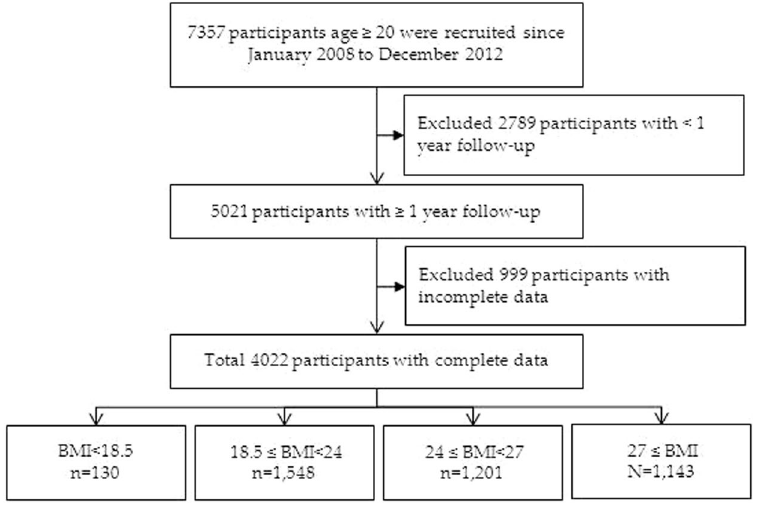
Figure 1. Flowchart of Patients